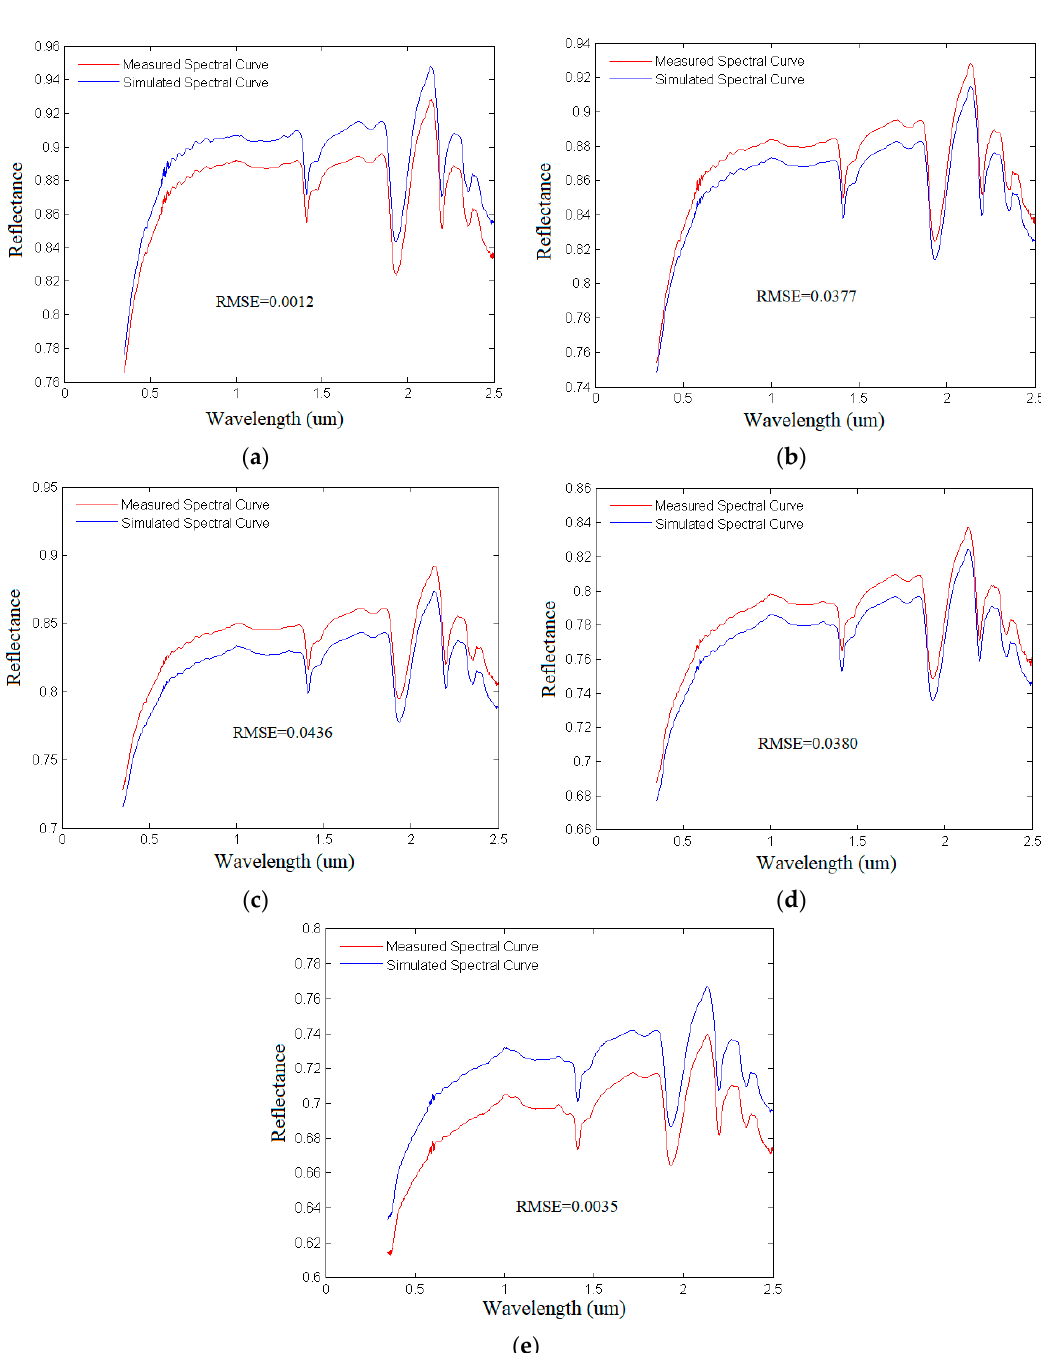
Figure 15. Comparison of the simulated and measured spectra of plagioclase at 20 ° ( a ), 30° ( b ), 40° ( c ), 50° ( d ), and 60° ( e ). In Figure 16, the reflectance of plagioclase at characteristic wavelengths of 1.93 µm and 2.20 µm with an incidence angle of 0° and azimuth of 210° is compared with that of the simulated spectra. The simulated spectra can reflect the law of reflectance as a function of angle, which indicates that the photometric parameters of plagioclase obtained by op- timized retrieval have high authenticity.